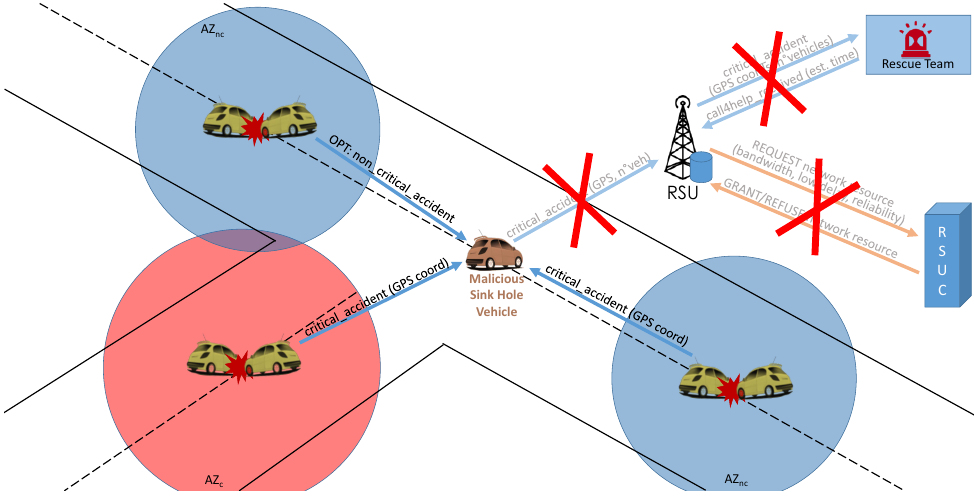
Figure 9. Example of sink hole attack on Emergency Services. The attacker receives and drops all the emergency requests from the vehicles in a certain area and this prevents the normal procedures of emergency forwarding and requests for special network resources. The red crosses over the faded arrows indicate the messages that would be exchanged in a regular scenario but, because of the attack, are not. The solution is to rely on SDN technology to elect only reputable intermediate nodes for V2V